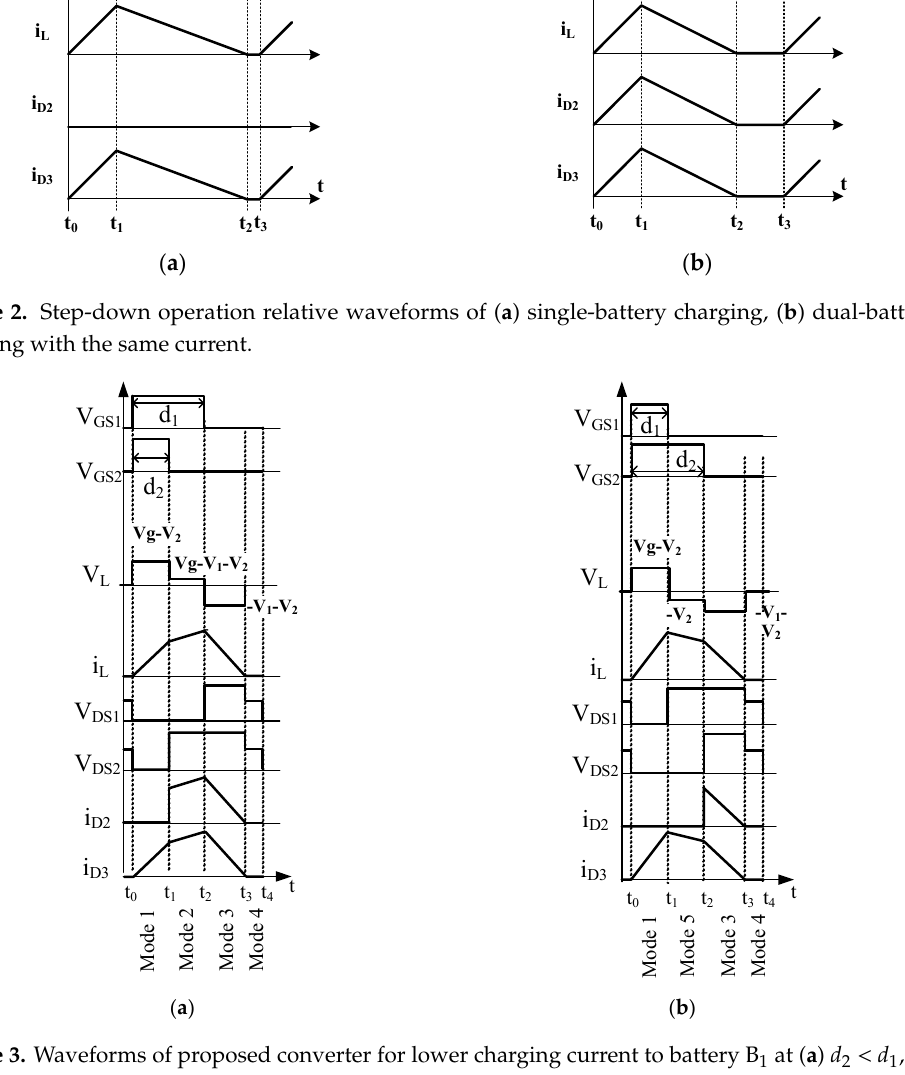
Figure 3. Waveforms of proposed converter for lower charging current to battery B 1 at ( a ) d 2 < d 1 , ( b ) d 2 > d 1